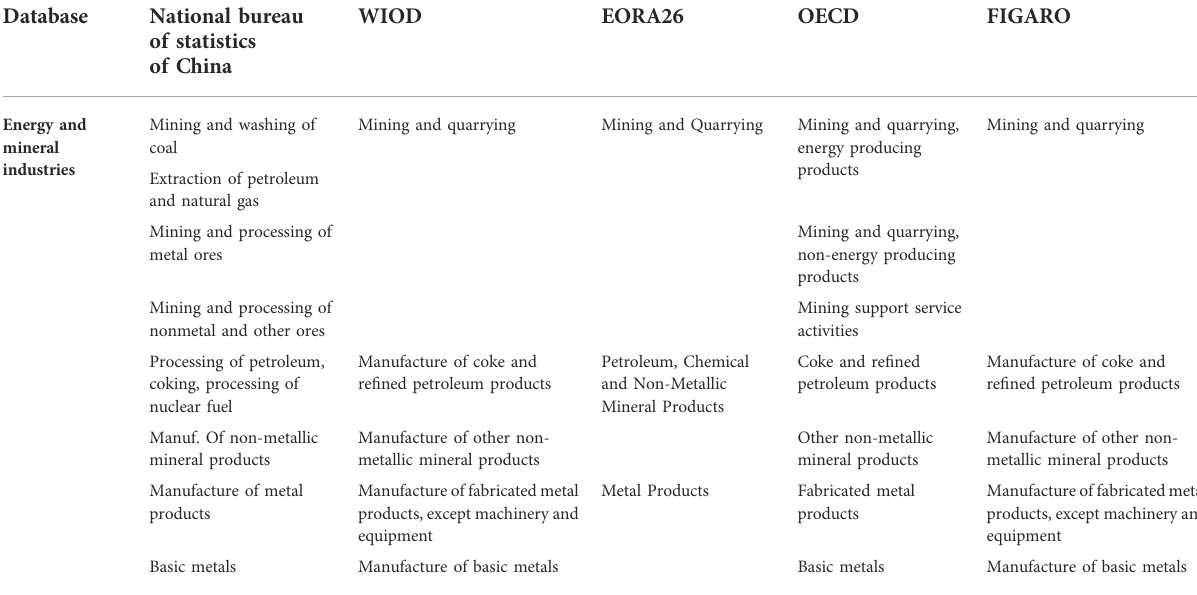
TABLE 1 Energy and mineral industries in the main input-output data in the